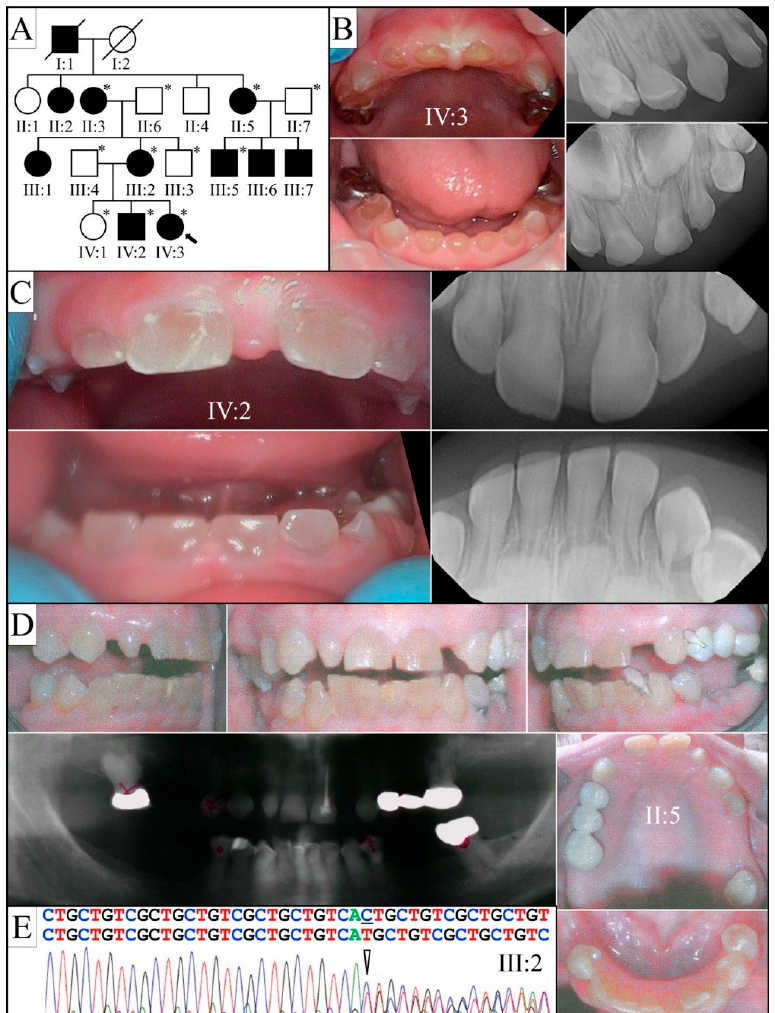
Figure 14. Family 11 from the United States ( A ): Four-generation pedigree of a family diagnosed with dentinogenesis imperfecta II. ( B ): The dental phenotype of the proband (IV:3 at age 16 months old), ( C ): proband ′ s older brother (IV:2 at age 7 years old), and ( D ): grandmother (II:6) presented with amber-brown, fractured and shed occlusal enamel, and exposed dentin of their teeth. The newly erupted permanent incisors of the proband ′ s brother were mildly discolored and opalescent. ( E ): Sequencing chromatogram showing the reverse complement of the disease-causing heterozygous DSPP − 1 frameshift mutation (NM_014208.3: c.3461delG, NP_055023.2: p.(Ser1154MetfsTer160) that segregated with the dentin phenotype. Key : * denotes enrolled participants.